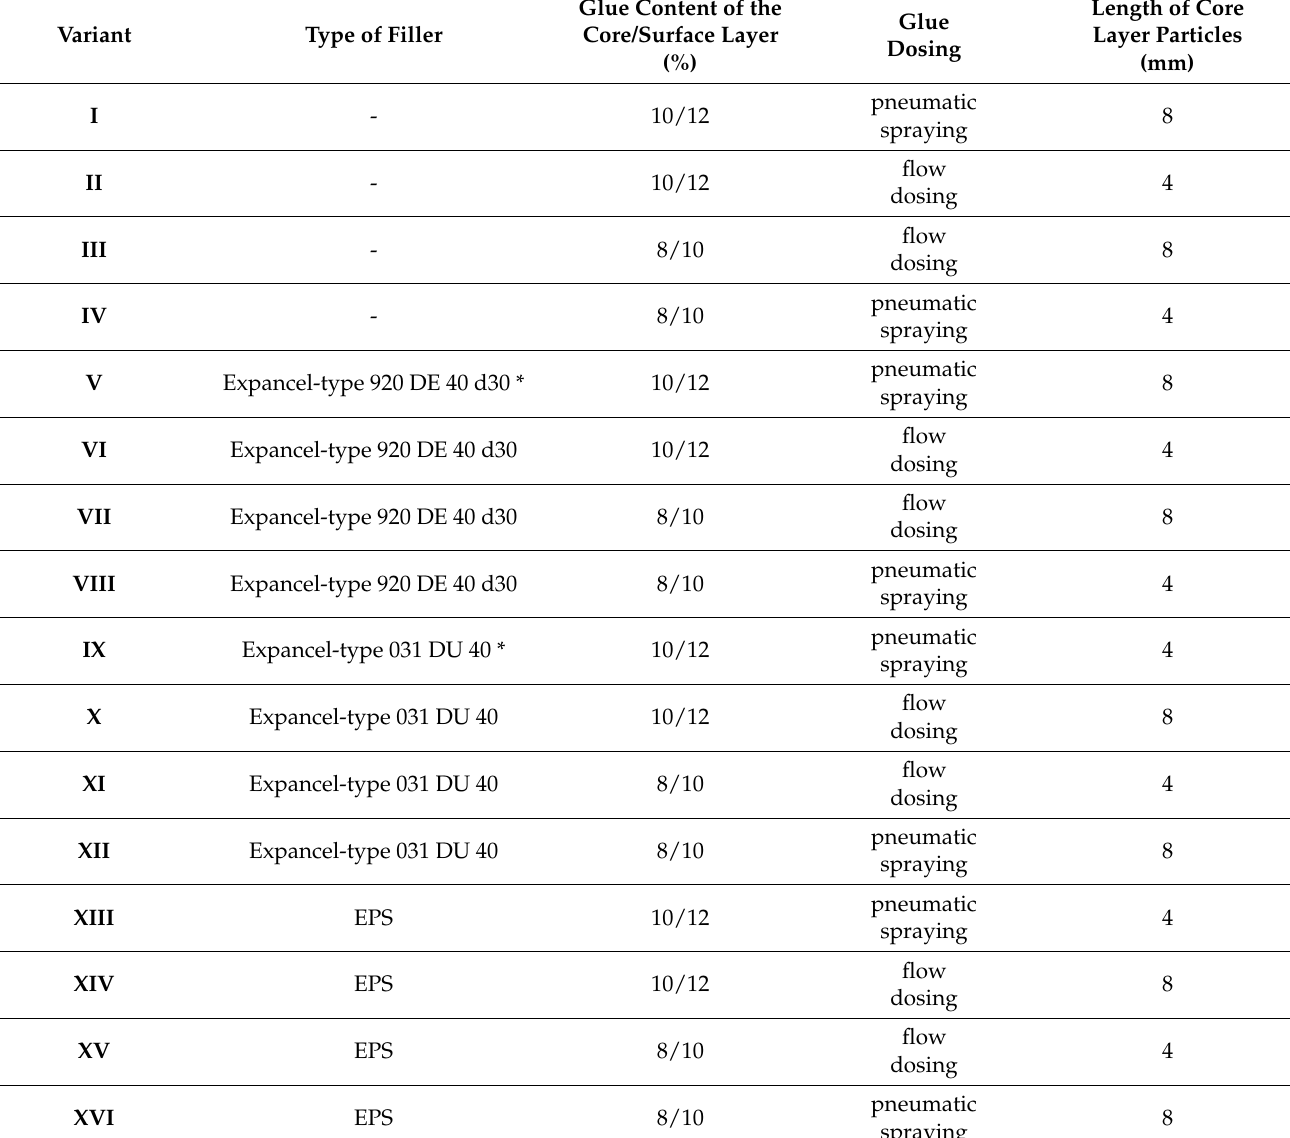
Table 1. Characteristics of individual variants, as part of which three-layer particleboards were